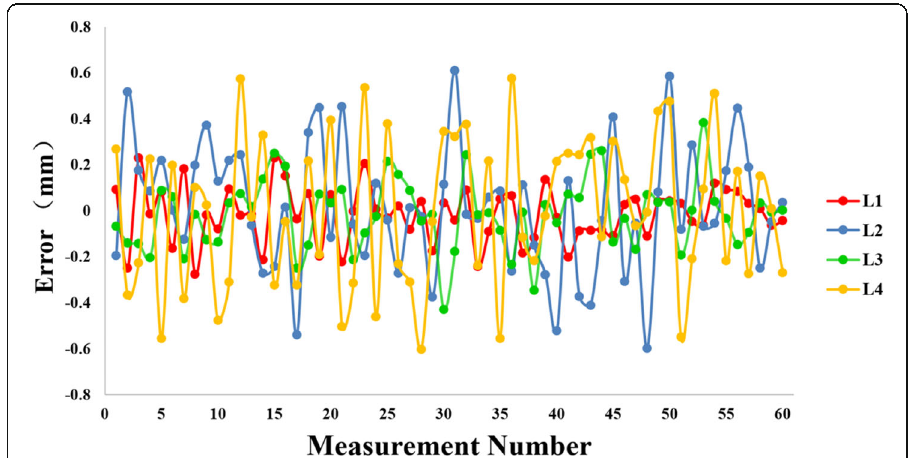
Fig. 10 The measurement errors between the two